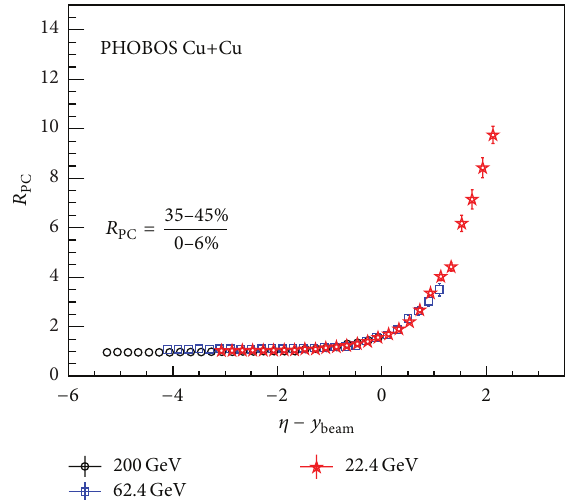
Figure 9: 𝑅 as a function of 𝜂 󸀠 = 𝜂 − 𝑦 PC at different energies.